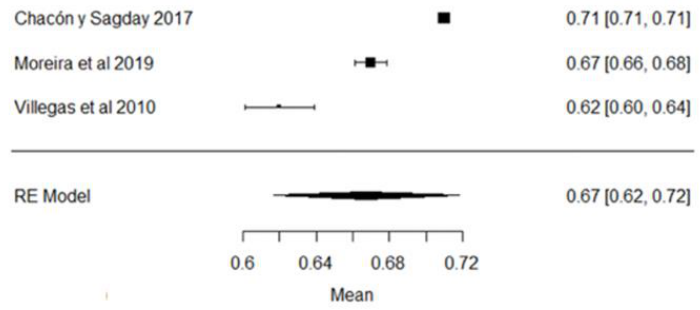
Figure 3. Ash forest plot [18,38,42].